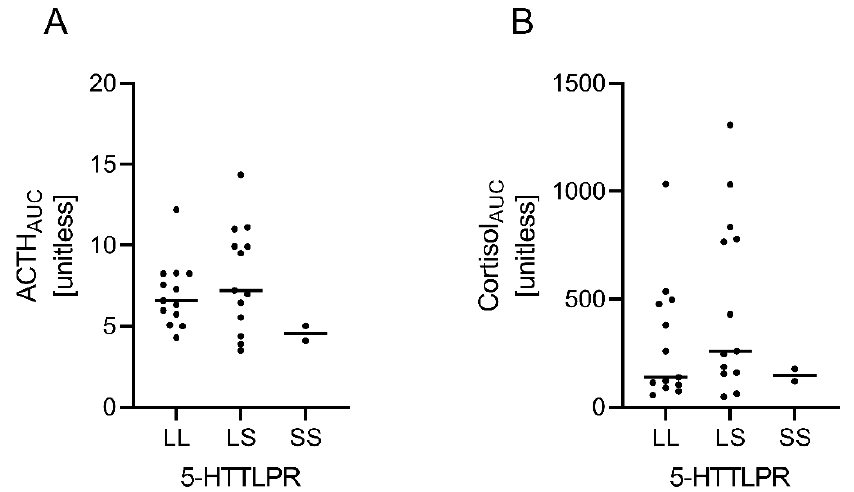
Figure 5. Explorative analyses of HPA axis responsiveness according to 5-HTTLPR genotype in OB. Comparison of the dex/CRH test indicators ( A ) ACTH AUC and ( B ) cortisol AUC (unitless) grouped by 5-HTTLPR genotype. Due to the small subgroup of individuals with the S/S genotype, comparison could only be explorative by nature, and no substantial differences were observed. ACTH, adrenocorticotropic hormone, AUC, area under the curve.